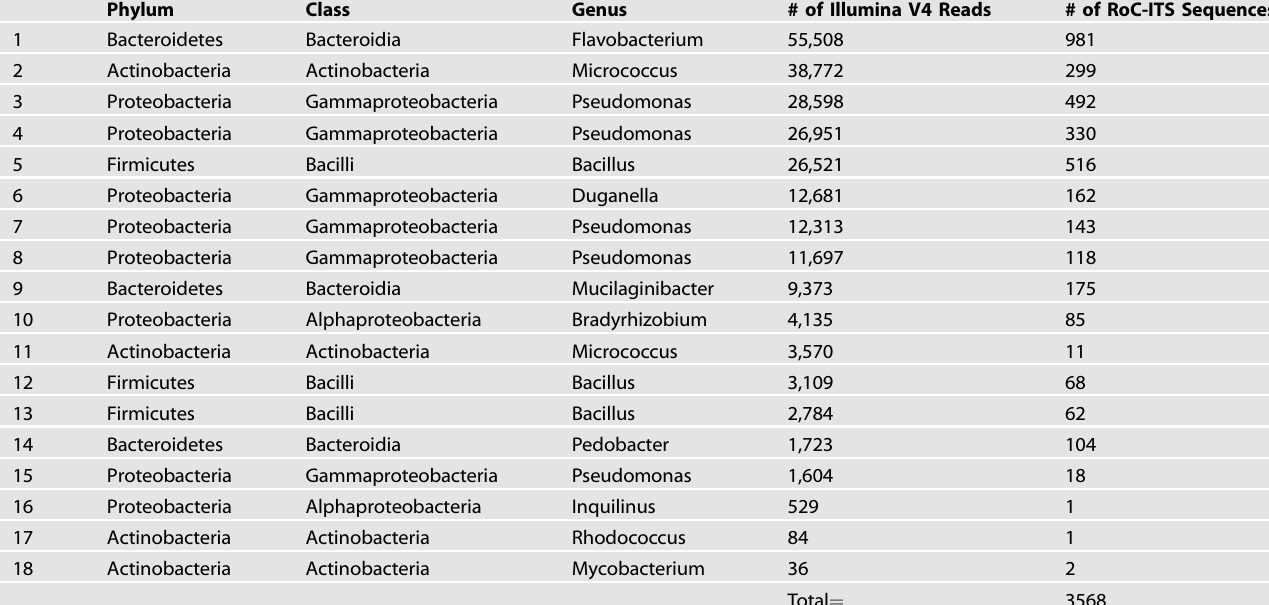
Table 2. Abundance of cd-hit clustered Illumina and RoC-ITS data at various taxonomic